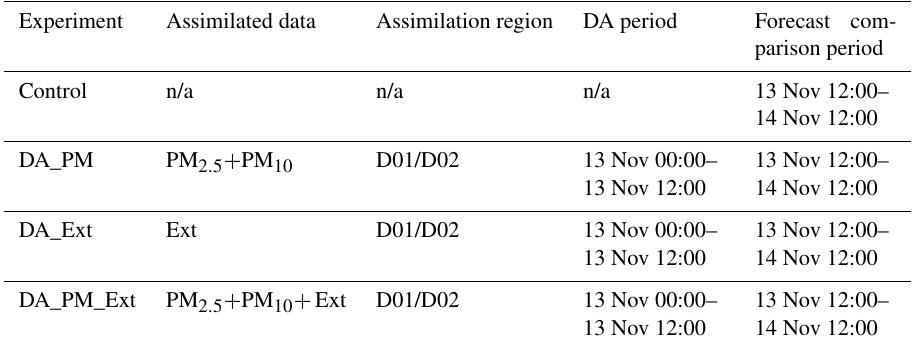
Table 1. Numerical experiment schemes. n/a – not applicable. Experiment Assimilated data Assimilation region DA period Forecast com-